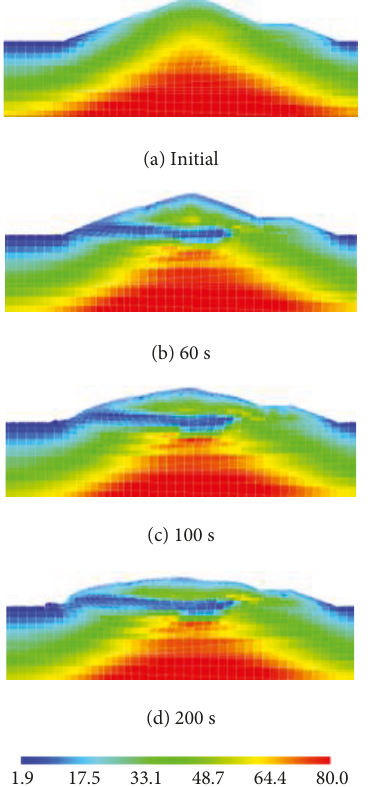
Figure 24: Distribution of mean e ff ective stress (unit: